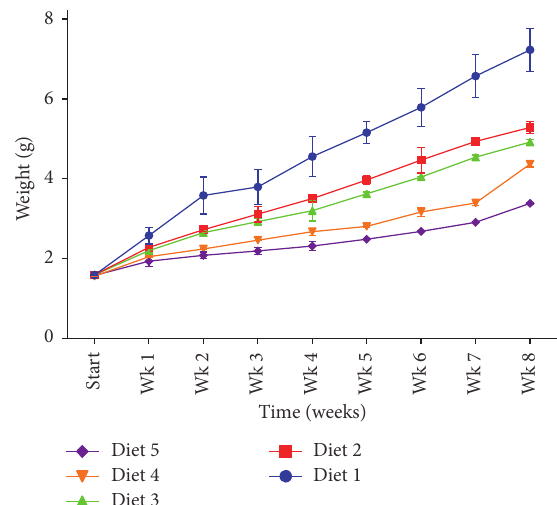
Figure 1: Weekly growth of Clarias gariepinus fed dried brewer’s yeast meal substituted for soybean